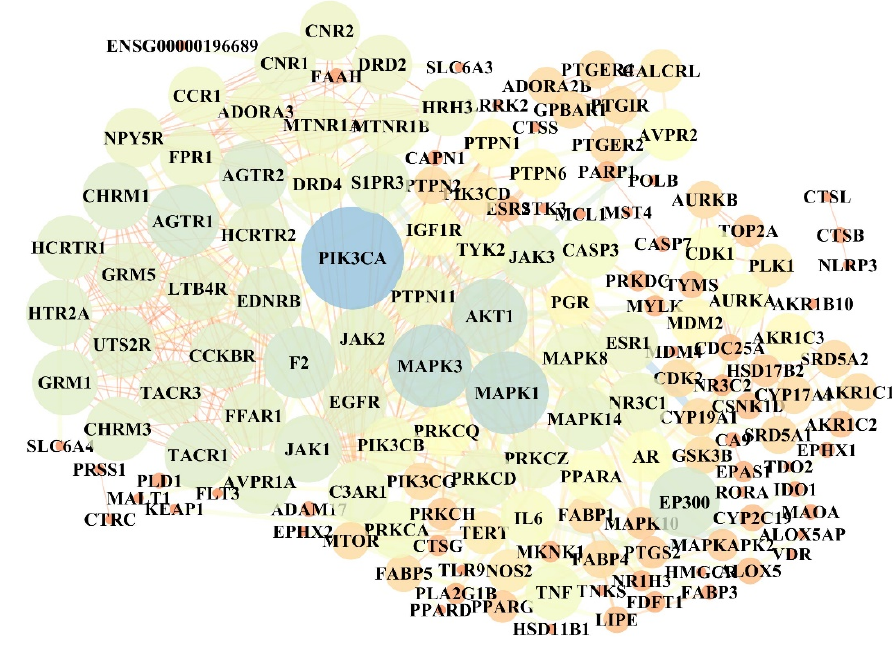
Figure 5. protein-protein interaction ( PPI ) diagram of target protein.